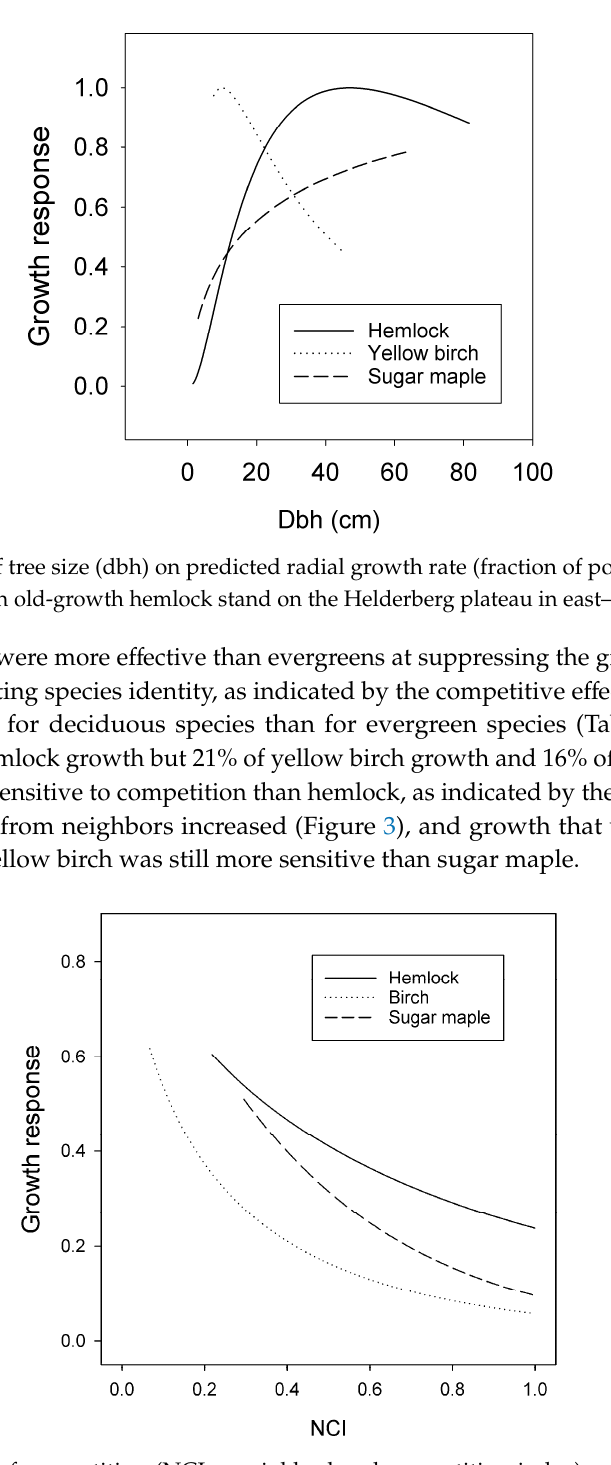
Figure 3. Influence of competition (NCI = neighborhood competition index) on predicted radial growth rate (fraction of potential growth) of three tree species in an old-growth hemlock forest on the Helderberg plateau in east–central New York. NCI is scaled relative to maximum value for each species.